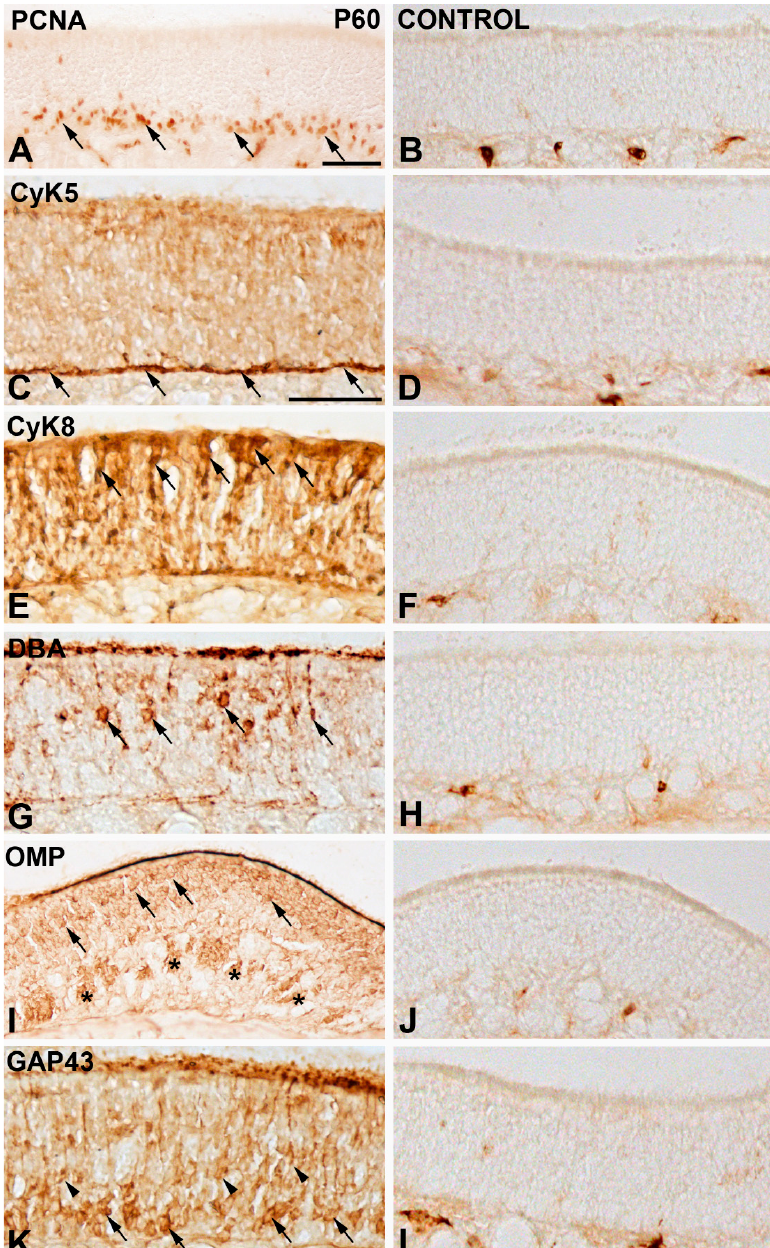
Figure 1. Patterns of staining for the different antibodies and the lectin used in the present study in the P60 mouse olfactory epithelium ( A , C , E , G , I , K ). Negative controls ( B , D , F , H , L ) included the replacement of primary antibodies by PBS. PCNA immunoreactive nuclei were observed in the basal olfactory epithelium (arrows in ( A )). Intense immunoreactivity against CyK5 was confined to the layer where the horizontal basal cells were located (arrows in ( C )). Strong immunoreactivity against CyK8 was detected in the cell somata located in the apical surface of the olfactory epithelium (arrows in ( E )). DBA-stained olfactory neurons appeared in the middle part of the olfactory epithelium (arrows in ( G )). Mature olfactory neurons expressing OMP (arrows in ( I )). Anti-OMP staining was also localized in nerve bundles dispersed throughout the lamina propria (asterisks). ( K ) GAP43-immunoreactive immature neurons were mainly located in the basal region of the olfactory epithelium (arrows in ( K )) and in sparse cell somata located in the central region (arrowheads in ( K ) Scale bars: 100 µ m in ( A – F ); 50 µ m in ( G